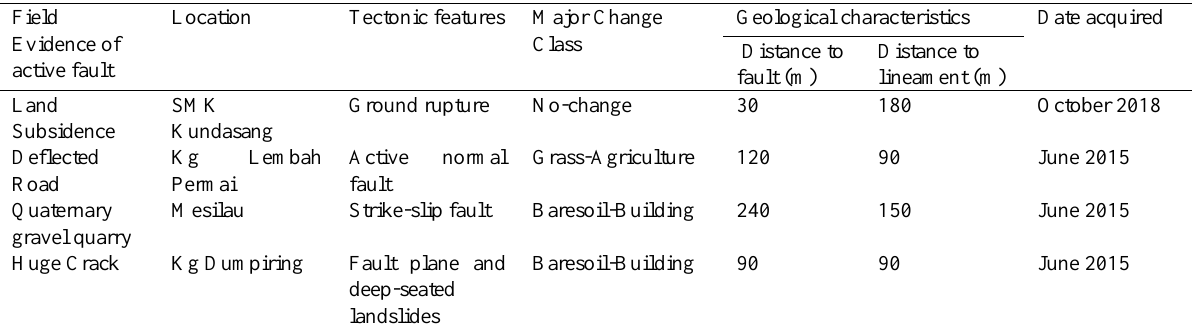
Table 4. LULC Change in tectonic features includes its geological